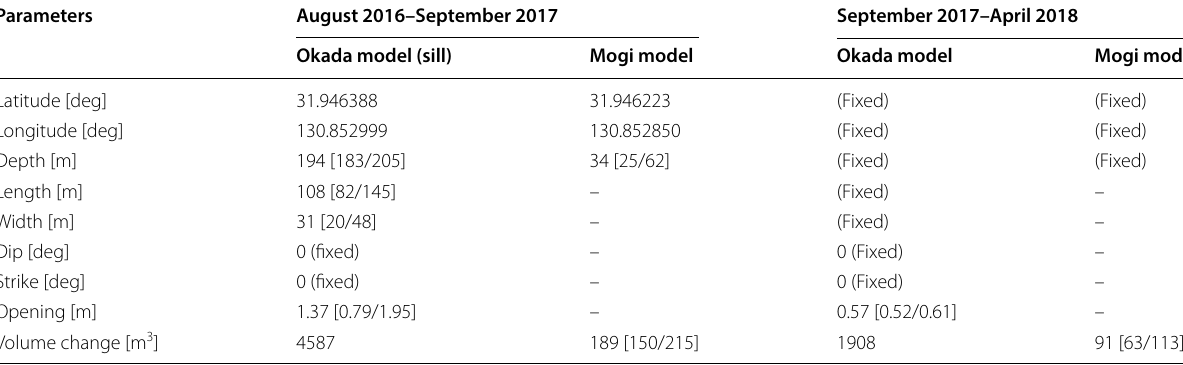
Parameter definitions are the same as those in Table 2. Model parameters for the period of 2017–2018, except for opening and volume change, are fixed as those for the period of 2016–2017